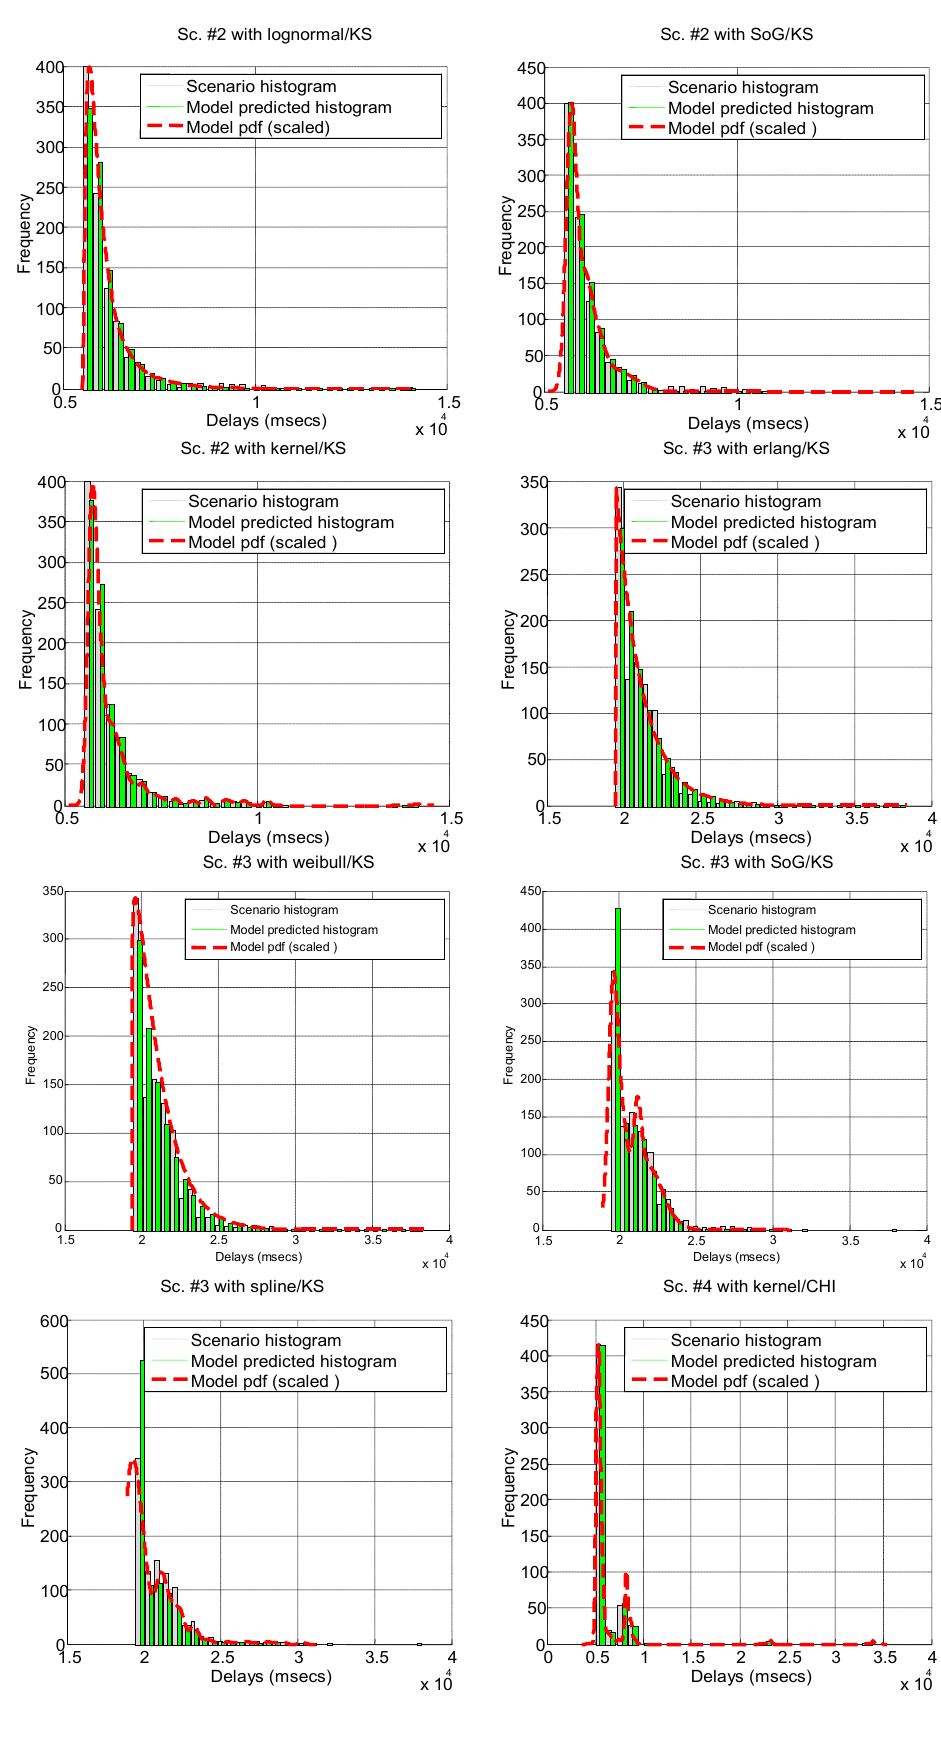
Figure 5. Illustrative histograms and fittings of the models that do not reject one or both hypothesis tests according to Table